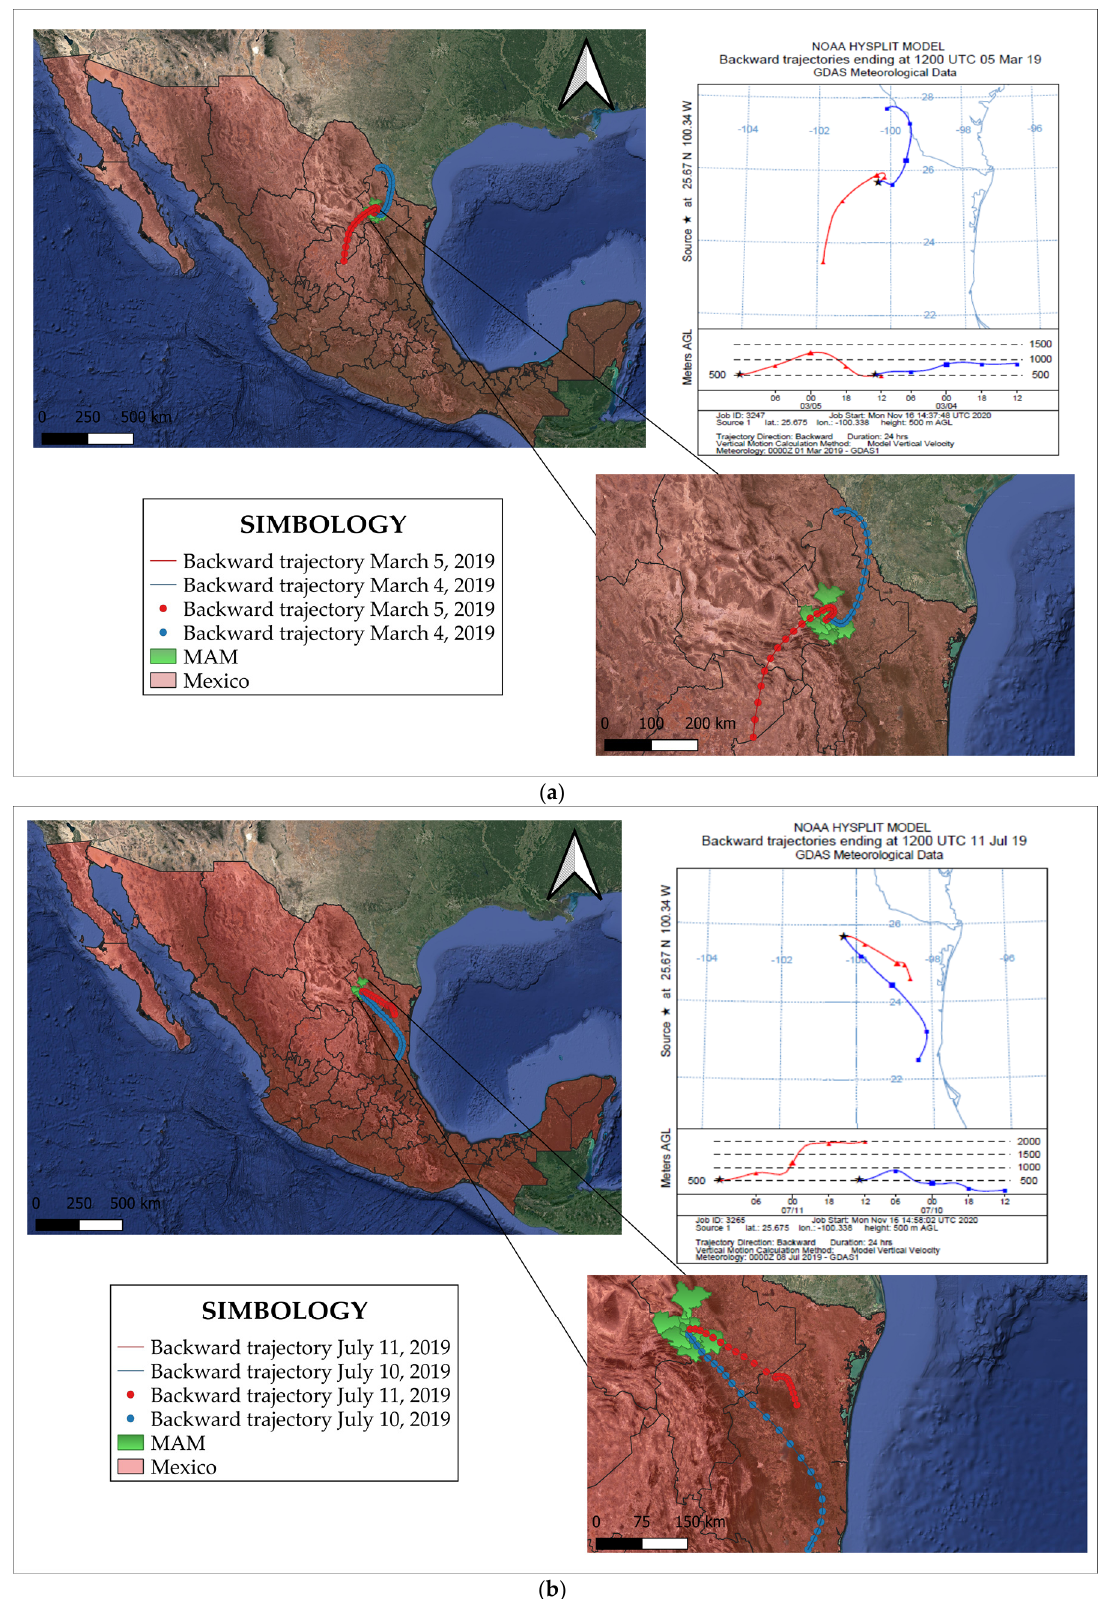
Figure 5. Air mass backward trajectories for the MAM ( a ) 5 March 2019 and ( b ) 11 July